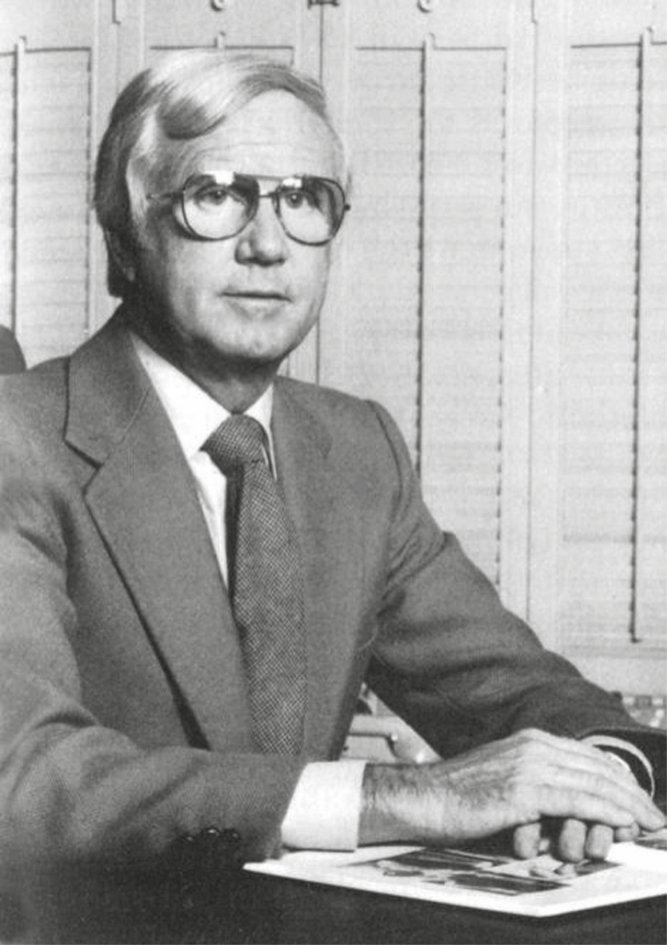
Thomas Baker, MD.